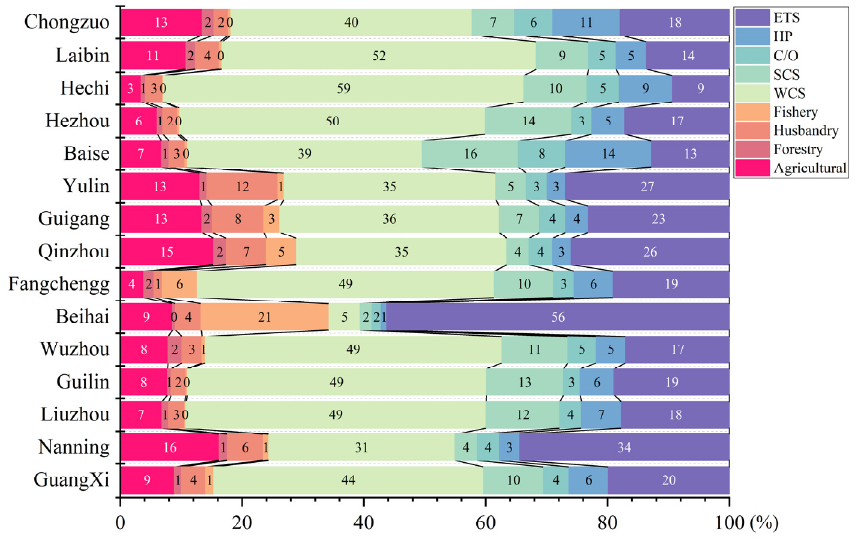
Figure 3. Composition of GEP in 2020.